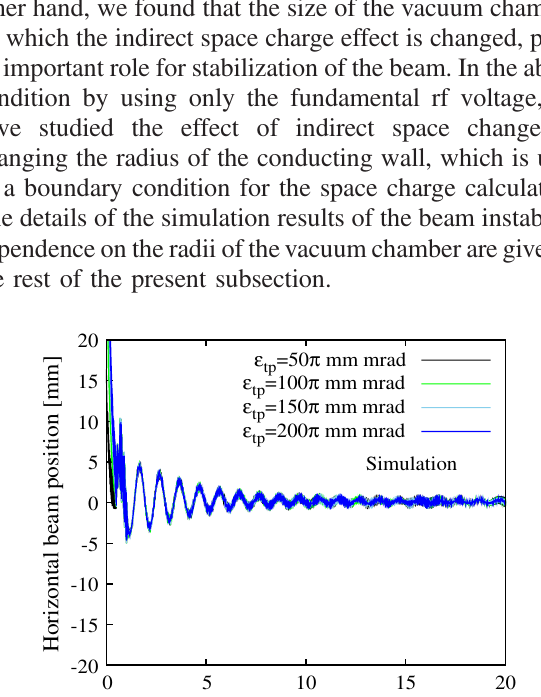
Fig. 14. The Landau damping effect is quite significant in the presence of strong space charge for any transverse beam